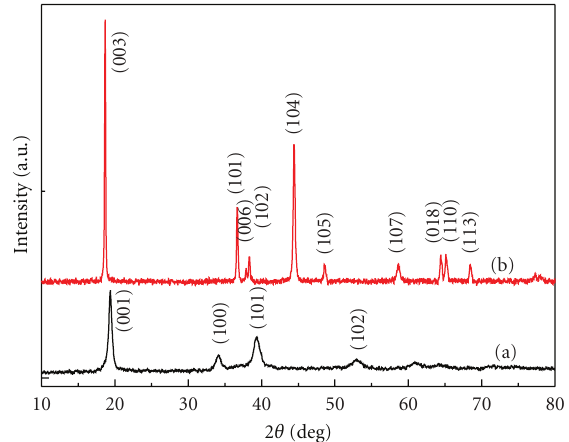
Figure 2: XRD patterns of (a) [Ni 0 . 5 Mn 0 . 3 Co 0 . 2 ](OH) 2 precursor and (b) final product Li[Ni 0 . 5 Mn 0 . 3 Co 0 . 2 ]O 2